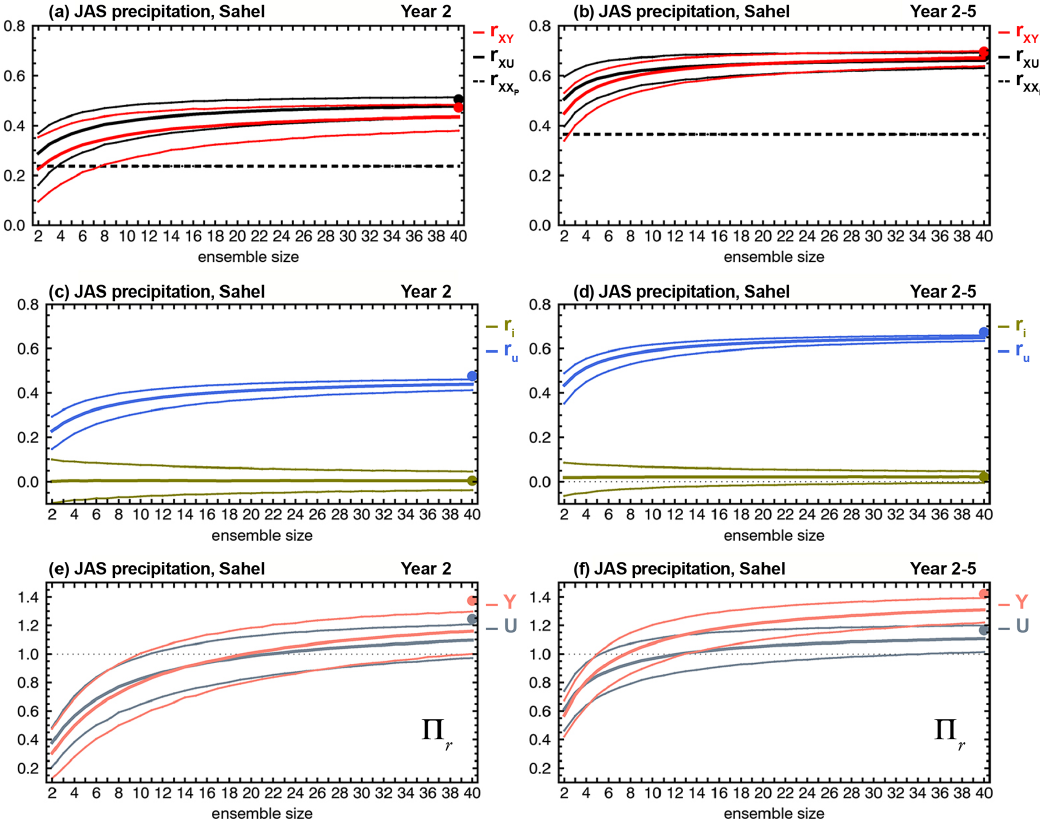
Figure 18. Dependence on ensemble size of (a, b) correlation skill of ensemble mean forecasts r XY (red) and ensemble mean simulations r XU (black); (c, d) contributions r u , Eq. (A16), in royal blue, and r i , Eq. (A17), in olive, to r XY ; and (e, f) ratio (cid:53) r , Eq. (8), of hindcasts (salmon) and uninitialized simulations (gray), for (a, c, e) Year 2 and (b, d, f) Year 2–5 precipitation hindcasts, averaged over the Sahel (10–20 ◦ N, 20 ◦ W–10 ◦ E). This region is highlighted in Fig. 15 above. Thick dashed lines indicate correlation skill r XX forecast. Thin curves are confidence intervals derived from the 5th and 95th percentiles of bootstrapping distributions generated from 10000 samples by random selection, with replacement, of ensemble members for each indicated ensemble size. Filled dots correspond to the actual 40-member ensemble predictions. Computations of r u , Eq. (A16), and r i , Eq. (A17), are done with m Y = 2 ... 40 members from the hindcast ensemble and, for each m Y , the 40 members from the uninitialized simulations ensemble. The verifying observations used to compute correlation skill are from the GPCP2.3 data set (Appendix